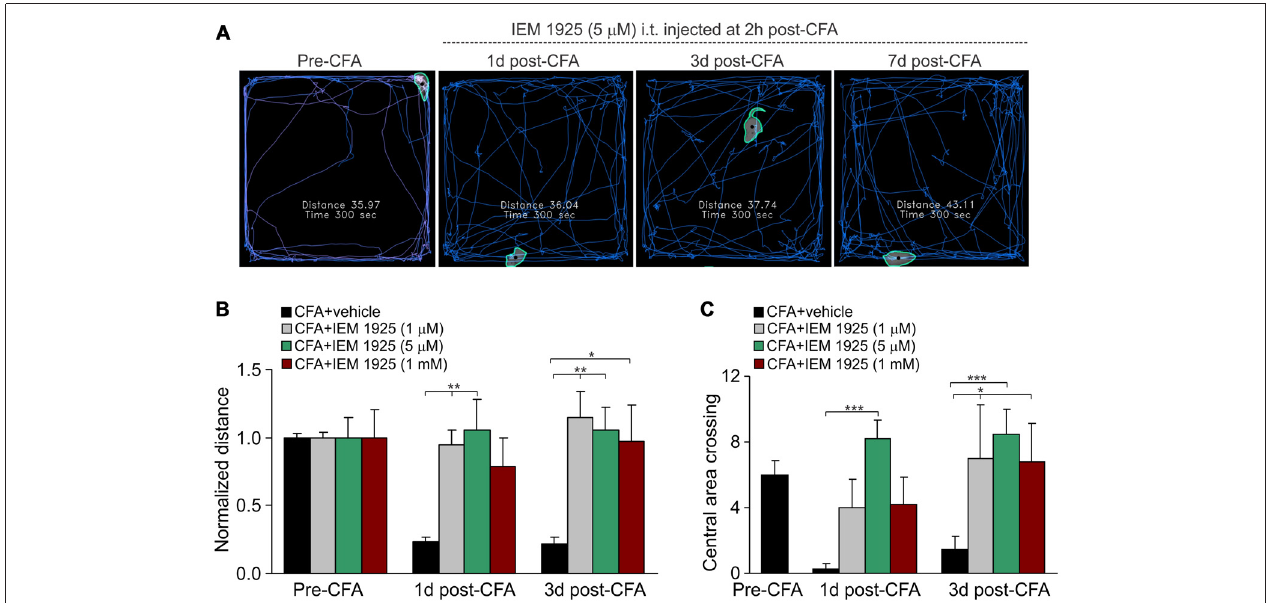
FIGURE 6 | The IEM-1925-induced relief in locomotive deficit and the anxiety-like behavior in CFA-inflamed animals. (A) The representative sketches of the open-field test, taken from the same animal, show the distance traveled by the animal before and after the induction of peripheral inflammation, followed by treatment with 5 µ M IEM-1925. (B–C) Summary of the restored both locomotive deficit (B) and suppressed activity of the animals with inflamed paw (C) after treatment with IEM-1925. Data are expressed as mean ± SEM. ∗ p < 0.05, ∗∗ p < 0.01, ∗∗∗ p < 0.001 vs. the indicated bar (the correspondent time-point in CFA-inflamed group without treatment). One-way ANOVA and Bonferroni post hoc